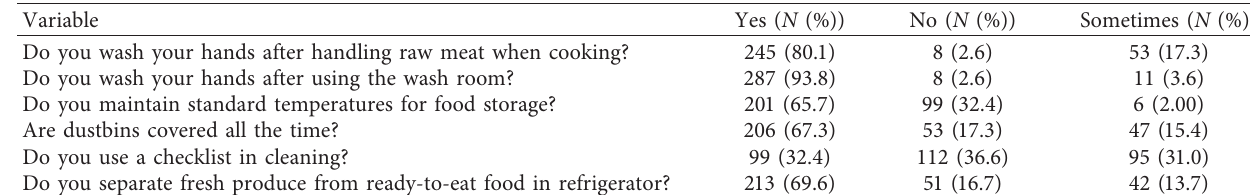
Table 4: Respondent workplace hygiene practices.